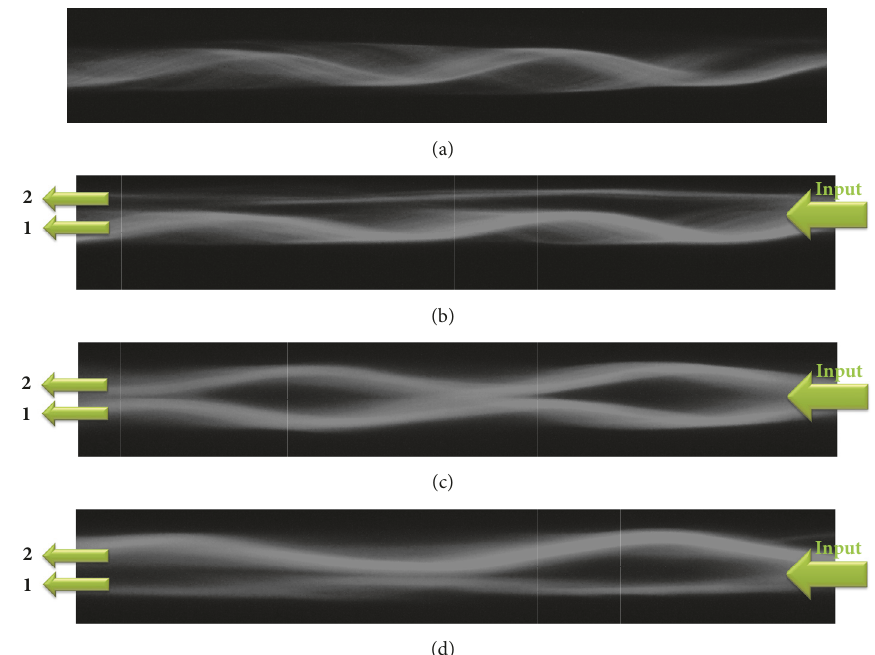
Figure 4: The guided light propagation by applying the fixed voltage of V app (1) = 2.2 V in channel 1 and applying voltages of V app (2) = 0 V, 1.5 V, 2.2 V, and 2.8 V in channel 2, which correspond to (a)–(d),